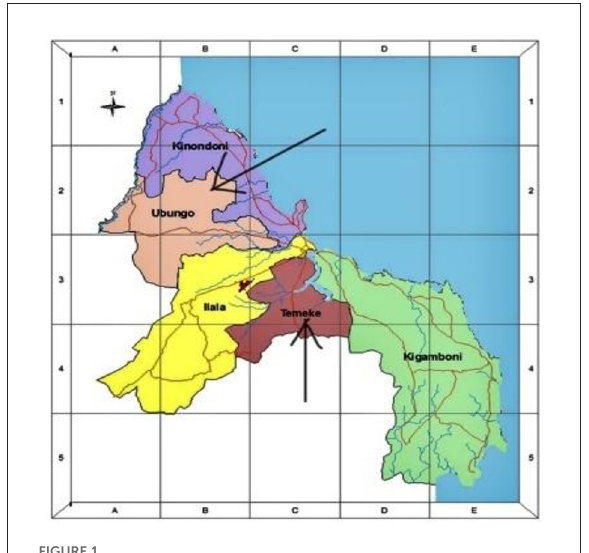
FIGURE1 Map of Dar-es-Salaam region showing the study sites (Ubungo and Temeke